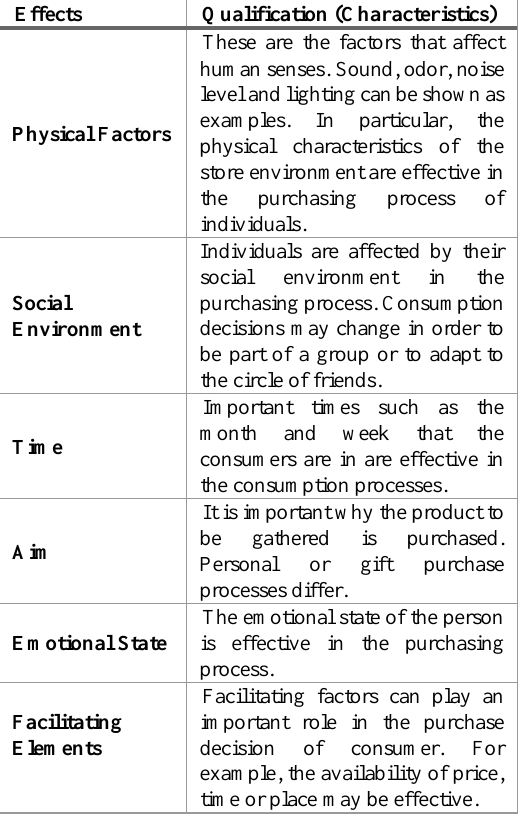
Table 3: Situational Effects Effects